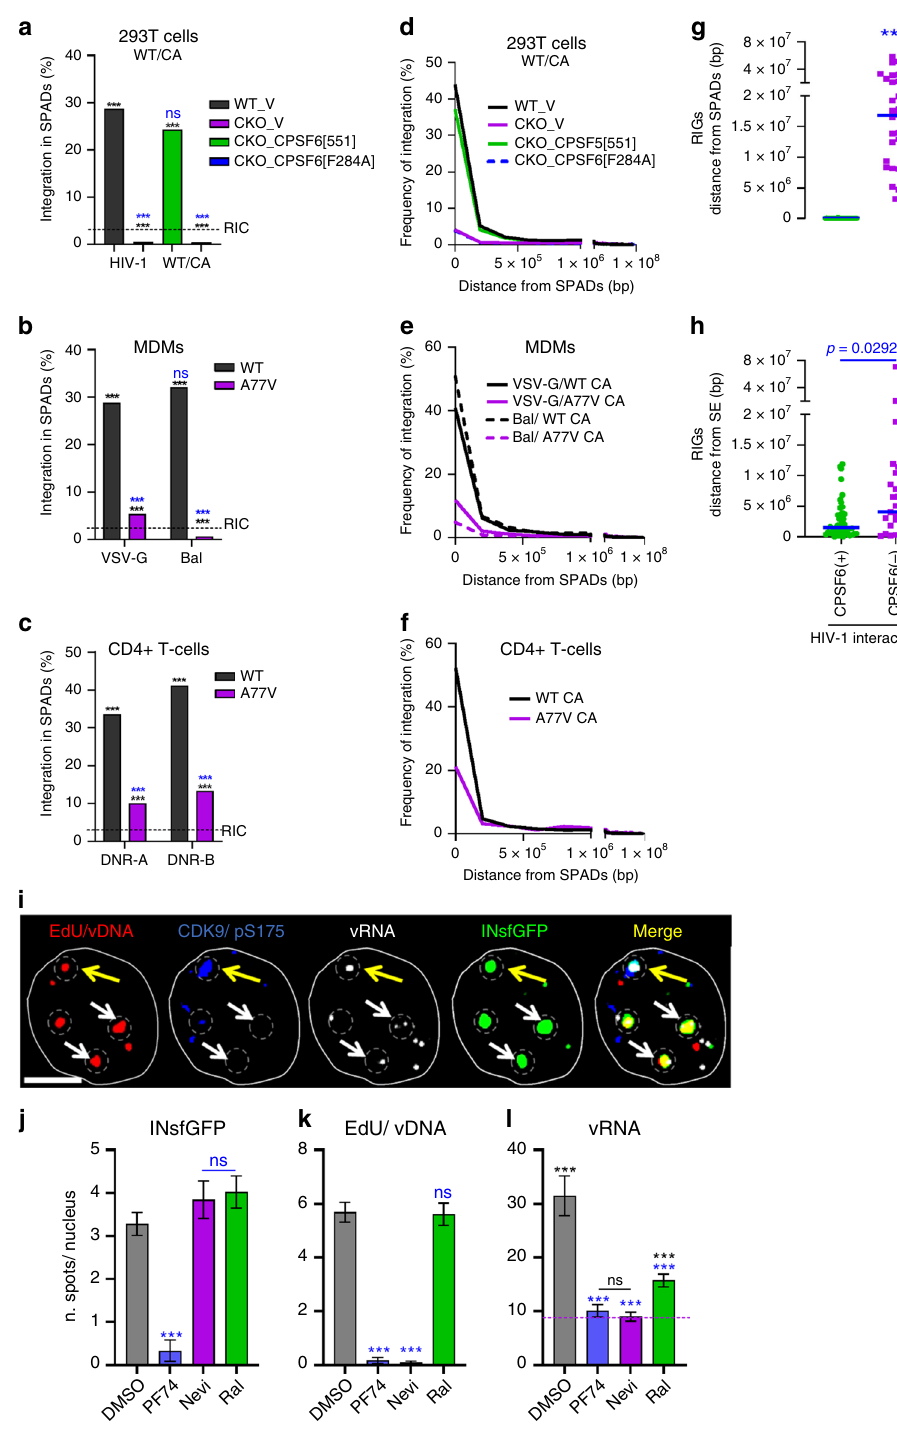
Discussion Quantitative imaging of HIV-1 infection demonstrated the for- mation of large IN-containing complexes in MDM cell nuclei. Further investigation of the intranuclear transport of VRCs revealed their accumulation in NSs, which are the preferred destinations of HIV-1 in MDMs and other cell types. HIV-1 transport to NSs is mediated by the CA – CPSF6 interaction but independent of reverse transcription. We also provide evidence that, at least in TZM-bl cells, the localization of VRCs in NSs stabilizes these complexes and facilitates infection.